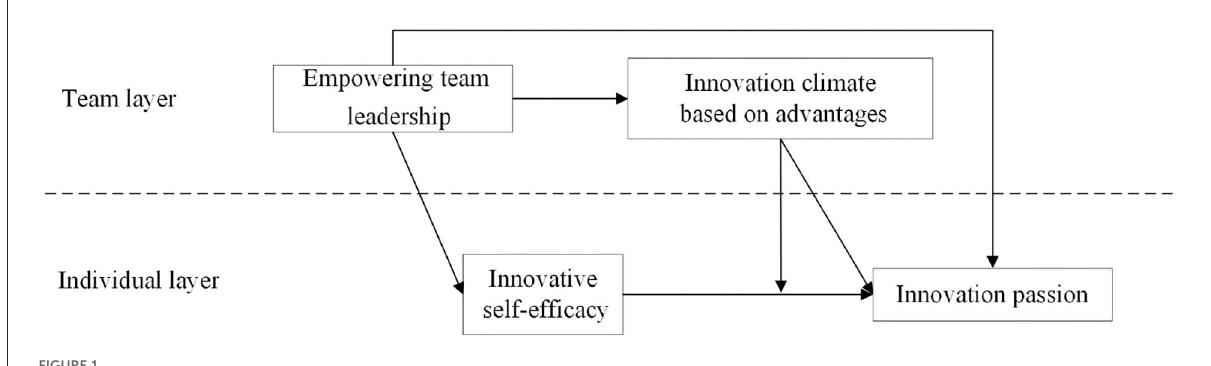
FIGURE1 The theoretical model of